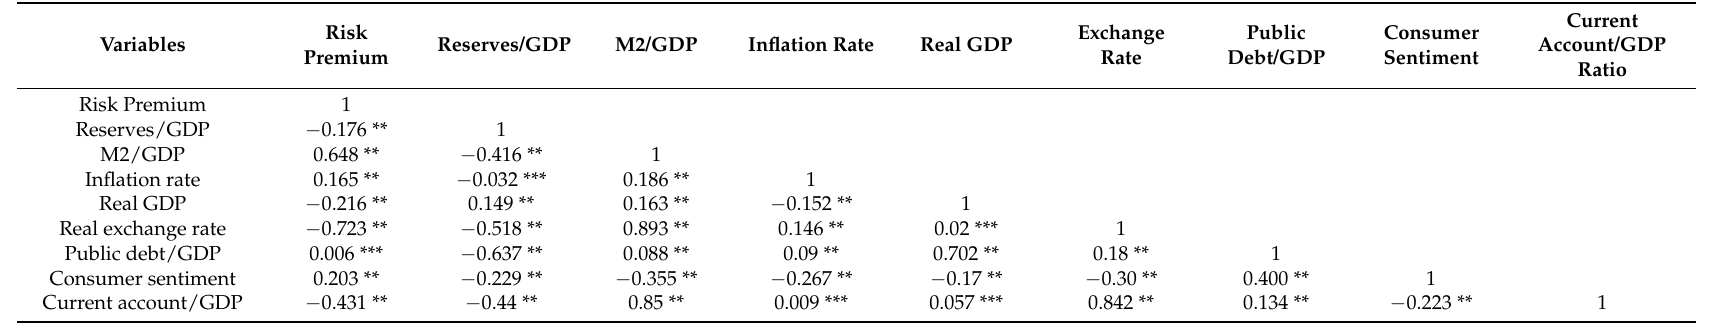
Table 1. Correlation